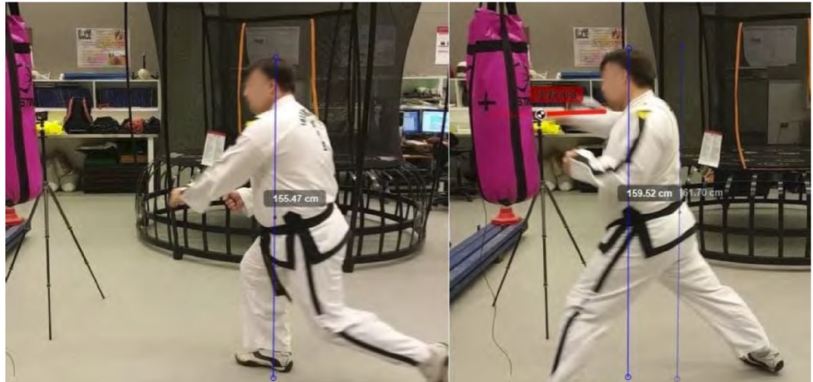
Figure 13. Reverse-step punch observed height differences during